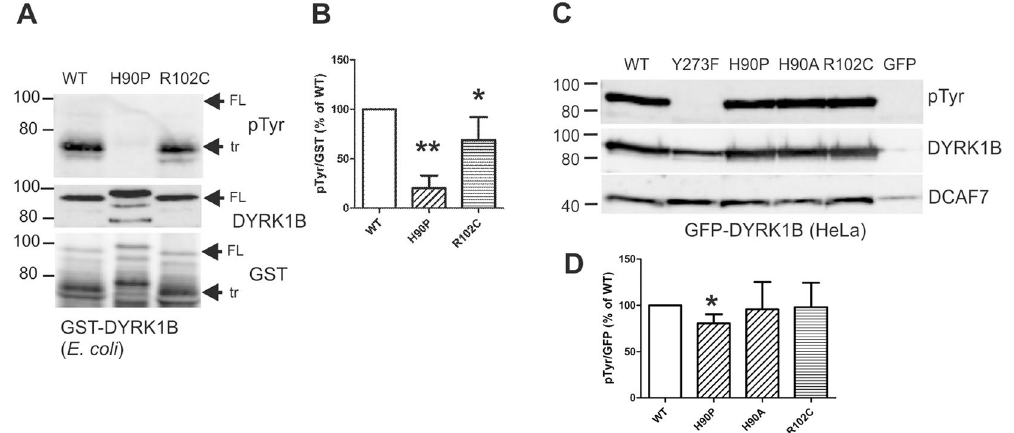
Figure 3. Tyrosine autophosphorylation of wild type and mutant DYRK1B. ( A , B ) Wild type and mutant GST- DYRK1B fusion proteins were purified from E. coli after overnight expression at 23 °C. These constructs resulted in C-terminally truncated (tr) protein and the full length (FL) protein. ( A ) Tyrosine-autophosphorylation was determined by immunoblot analysis with a phosphotyrosine-specific antibody (pTyr). ( B ) For quantification, pTyr band intensities were normalized for GST immunoreactivity. The column diagram shows the results (means and SD) of 5 independent experiments. ( C , D ) HeLa cells expressing wild type and mutant GFP- DYRK1B constructs were extracted using a non-denaturing lysis buffer with Igepal CA-630. GFP fusion proteins were immunoprecipitated and analysed by immunoblotting. The same blots were used to detect co- precipitated DCAF7. For quantification, pTyr band intensities were normalized for GFP immunoreactivity. Panel C shows the Western blots of a representative experiment and the column diagram ( D ) illustrates the results (means + SD) of 5 independent experiment (n = 3 for H90A). Significant differences between WT and mutant DYRK1B are marked (One sample t-test, * p < 0.05, ** p < 0.01). Uncropped images of the Western blots are provided as supplementary